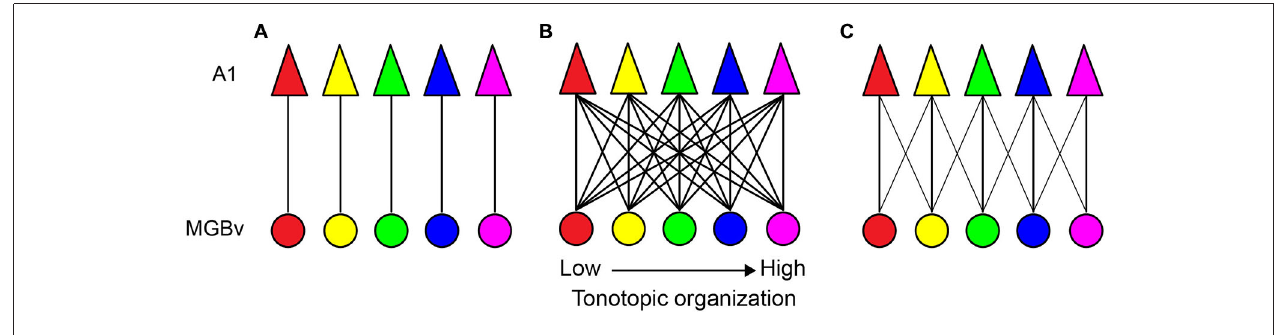
convergent model. All neuron clusters are heavily connected. (C) A constrained divergent and convergent model. A cluster of A1 neurons receives convergent thalamocortical inputs from sound frequencies within 1/3 octave of different best